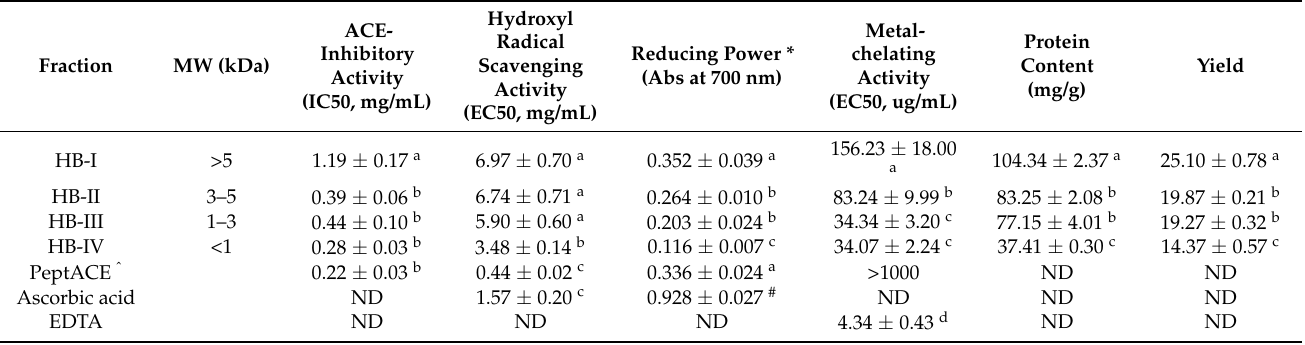
Table 1. The ACE-inhibitory activity, antioxidant activities, protein content, and yield of ultrafiltration fractions obtained from